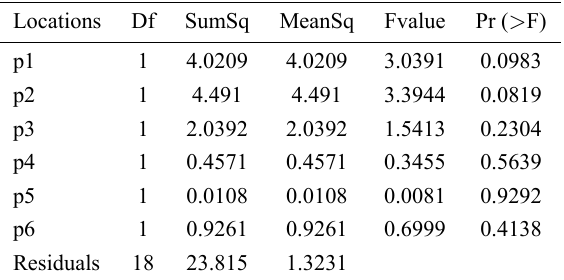
Table 4. ANOVA effect of wrestlers age on the location of weak links in low threshold tests.